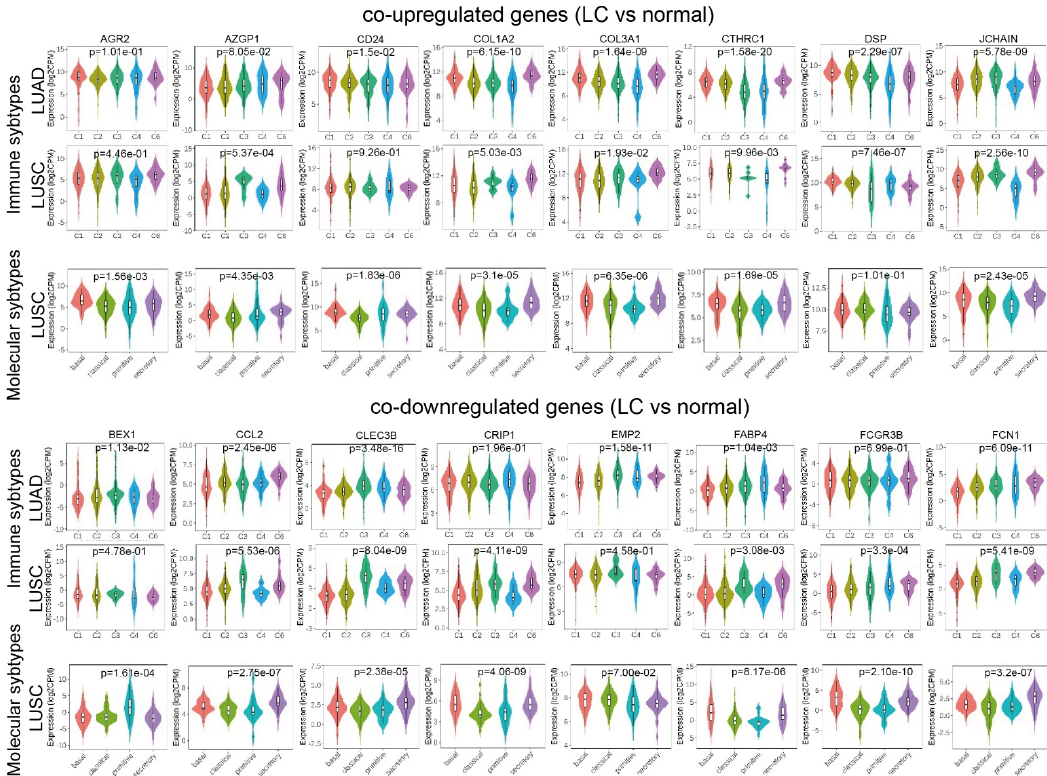
Figure 2. Expression of the top co-up- or co-downregulated genes across different immune and molecular subtypes of lung adenocarcinoma (LUAD) or lung squamous cell carcinoma (LUSC). The immune subtypes were: C1 (wound healing); C2 (IFN-gamma dominant); C3 (inflammatory); C4 (lymphocyte depleted); C5 (immunologically quiet) and C6 (TGF-b dominant), as defined in Thorsson et al. [13]. The molecular subtypes of LUSC contained basal, classical, primitive, secretory tumors. LUAD immune subtypes, n=C1,83;C2,147;C3,179;C4,20;C6,28. LUSC immune subtypes, n=C1,275;C2,182;C3,8;C4,7;C6,14. LUSC molecular subtypes, n=basal 42, classical 63, primitive 26, secretory 39.